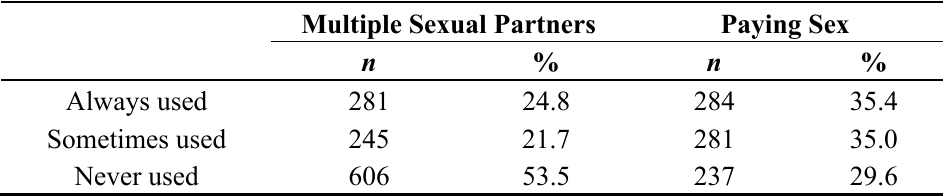
Table 5. Participants’ use of condoms with sexual partners.